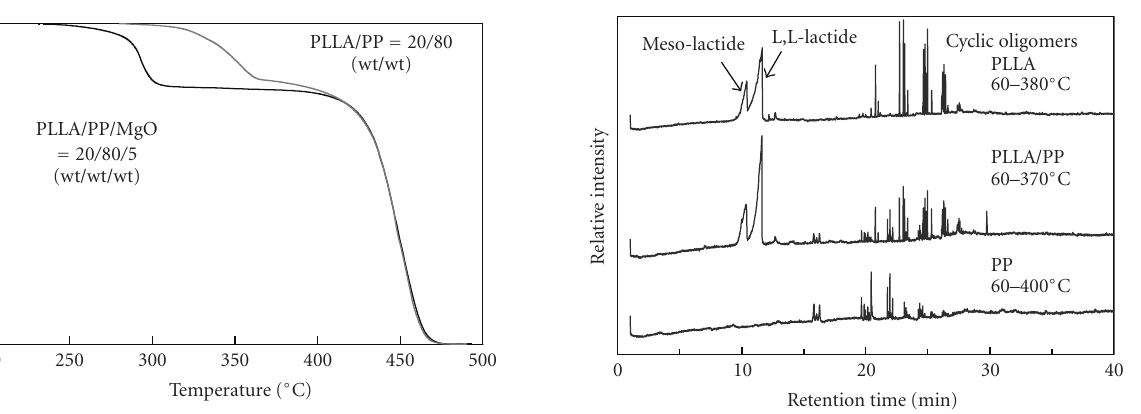
Figure 4: Pyrolysis-GC/MS analysis of PLLA, PP, and PLLA/PP. ϕ = 9 ◦ Cmin − 1 . measured at ϕ = 9 ◦ C min − 1 are illustrated. The TG